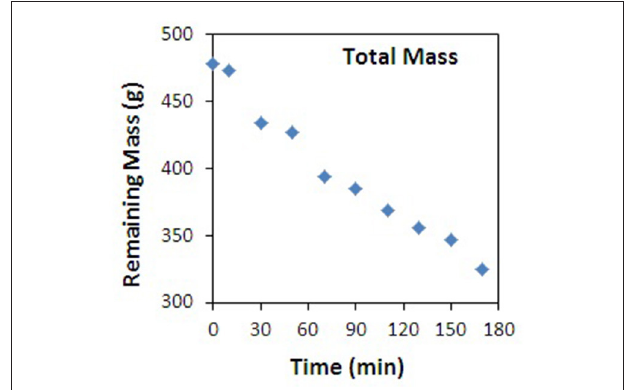
FIGURE 9 | Modeling of selected profiles for the ARH well at: (A) 5min, (B) 10min, (C) 15min, and (D) 20min.